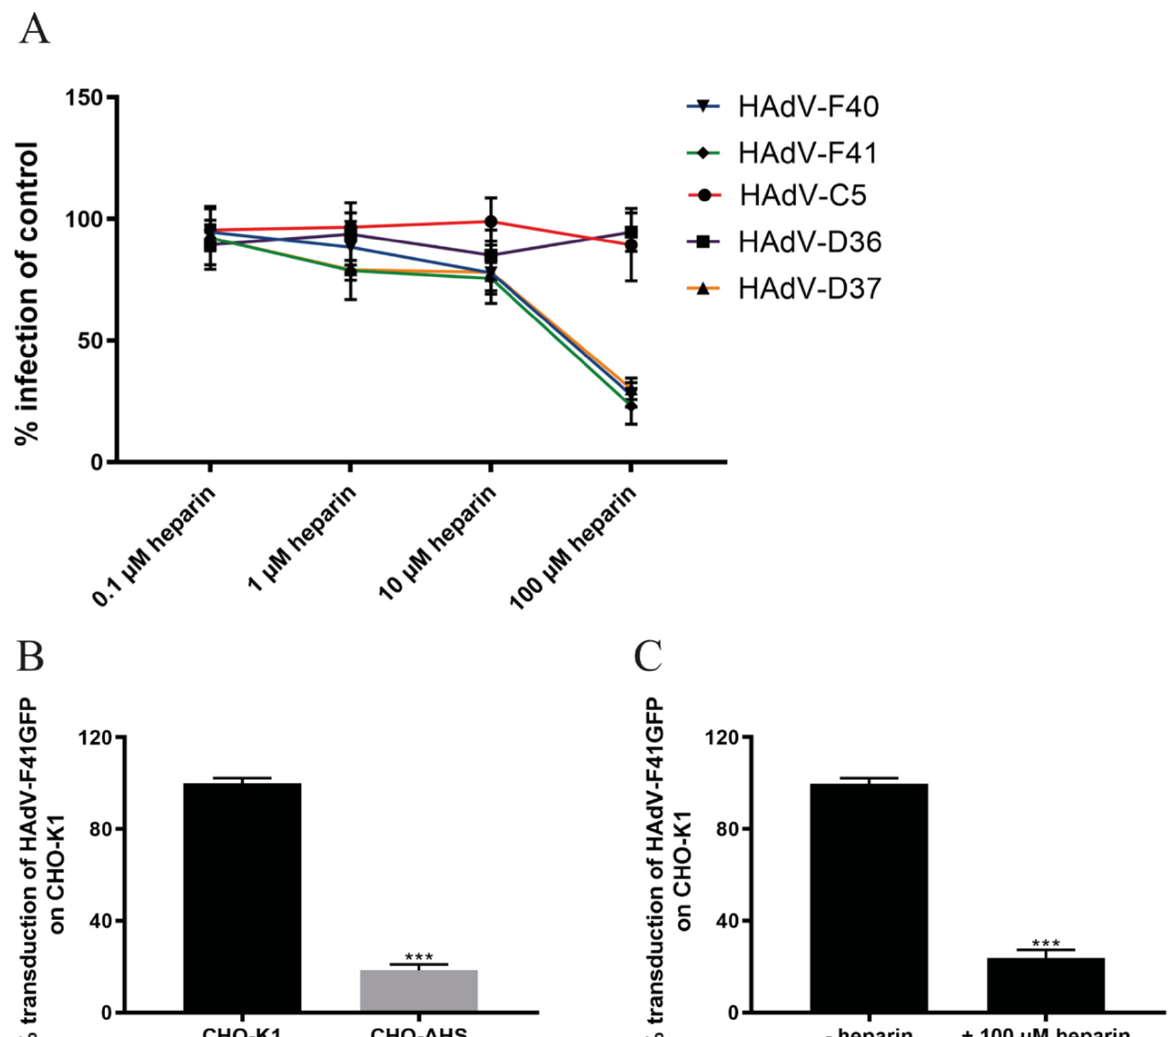
Figure 3. Importance of heparan sulfate on infection and transduction. ( A ) Infection of heparin pretreated HAdVs on A549 cells. The number of infected cells were quantified by immunofluorescence and shown as % infection of untreated HAdVs. ( B ) Transduction of HAdV-F41 GFP vector on CHO cells expressing or lacking heparan sulfate (HS) and ( C ) transduction of heparin pretreated HAdV-F41 GFP vector on CHO-K1 cells. The parental cell line CHO-K1 expresses glycosaminoglycans and CHO- ∆ HS specifically lacks heparan sulfate but expresses other glycosaminoglycans. The number of infected/transduced cells were quantified by immunofluorescence and shown as % infection of untreated A549 cells. All experiments were performed three times with duplicate samples in each experiment. Error bars represent mean ± SEM. *** P < 0.001 versus control.